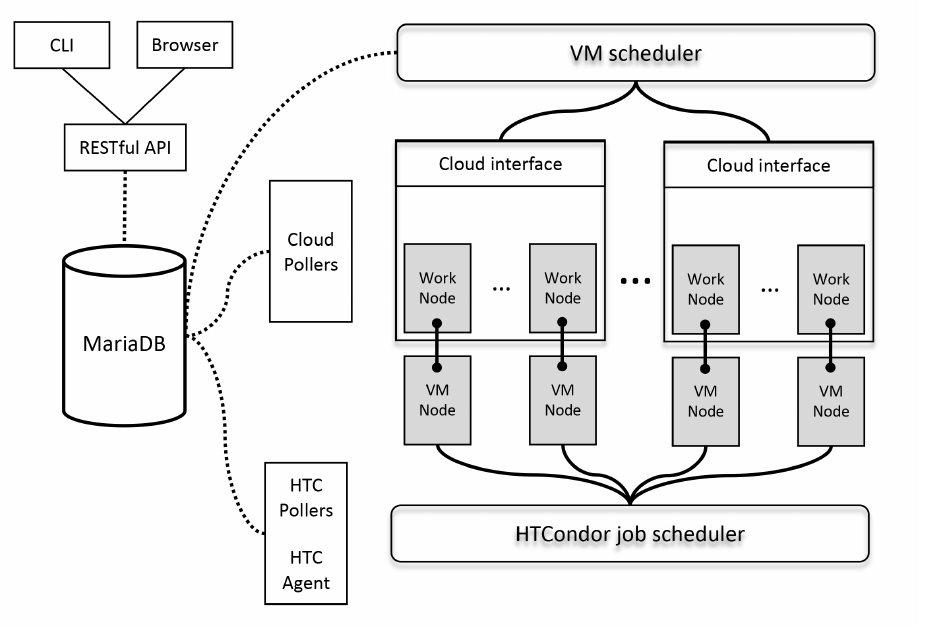
Figure 1. Overview of the cloudscheduler and HTCondor distributed compute cloud. The primary change is the introduction of the MariaDB for keeping track of the state of the system and “pollers” to gather information from the clouds and the job scheduler. The information in the database is used for scheduling, management and